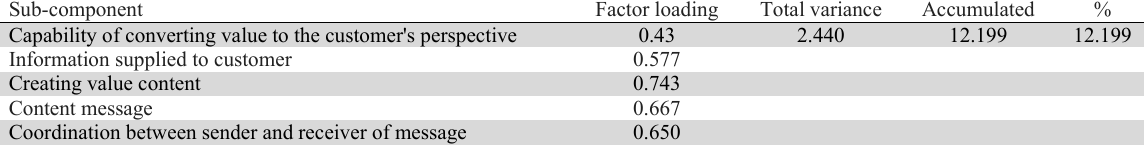
The summary of the sub-component influencing on organization of content marketing Sub-component Factor loading Total variance Accumulated Capability of converting value to the customer's perspective